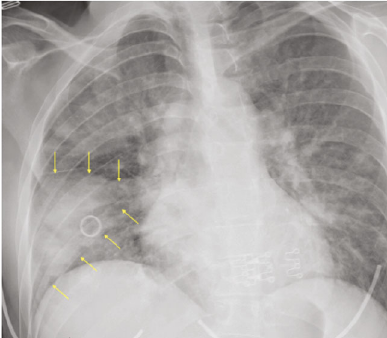
Figure 1: AP chest radiograph on initial presentation demonstrating a wedge like consolidation in the right-lower-lobe delineated by yellow